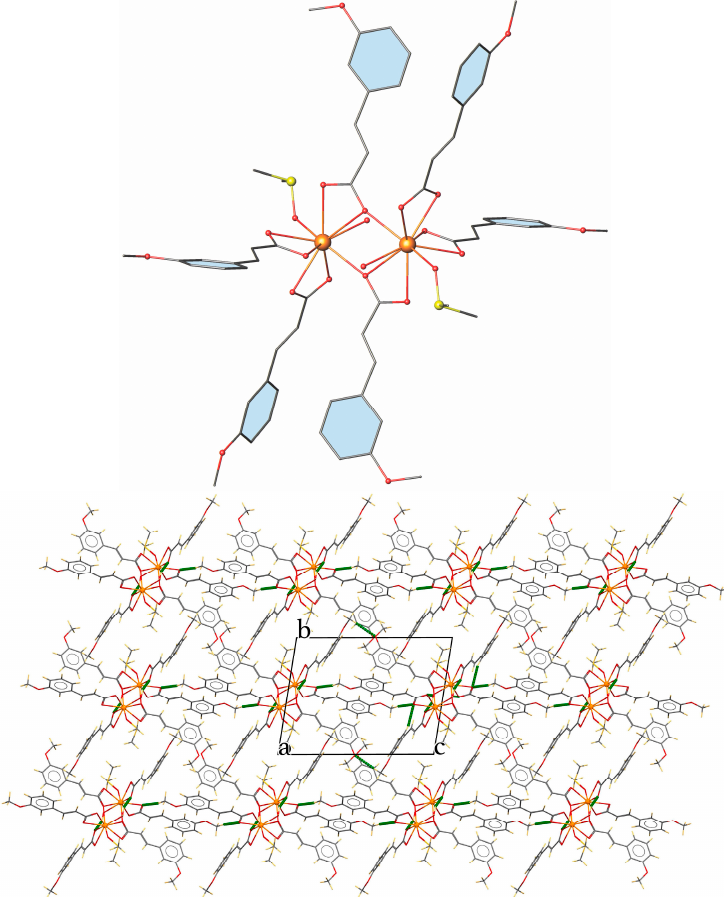
Figure 1. Top: Molecular structure of 1 . Color code: orange Ln, yellow S, red O, grey C. Hydrogen atoms have been omitted for clarity. Bottom: Packing arrangement of 1 viewed along the a crystallographic axis. The hydrogen bonding is indicated by green dashed lines.